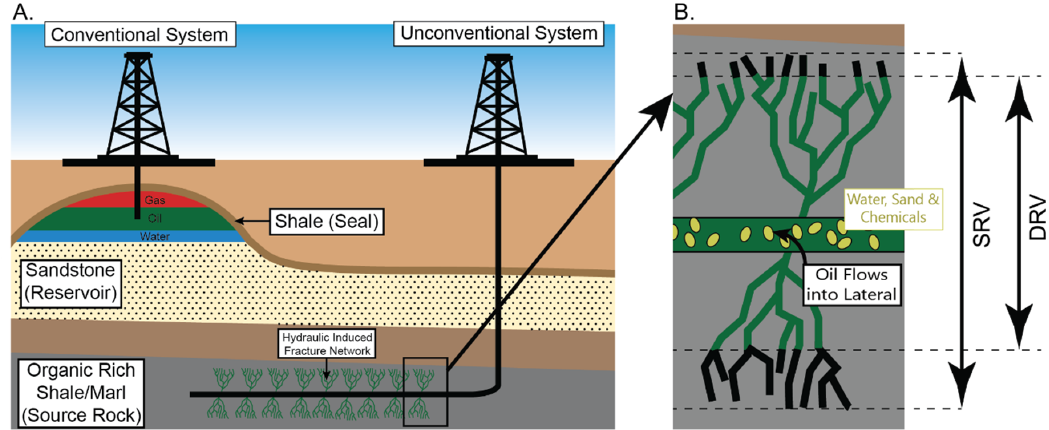
Figure 1. ( A ). Schematic illustration of the difference between “conventional” and “unconventional” petroleum systems and the target formations for production. ( B ). Illustration of the difference between the “Stimulated Rock Volume” (SRV) and the “Drained Rock Volume” (DRV) in an unconventional production formation.